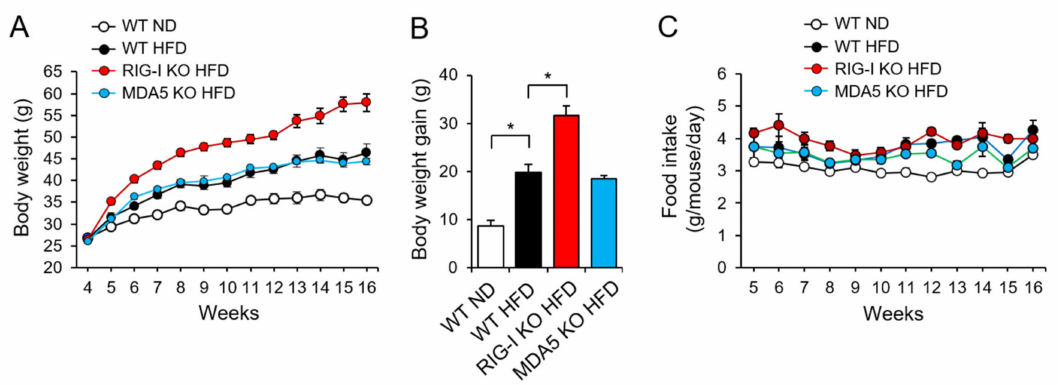
Figure 1. RIG-I deficiency exacerbates high-fat diet-induced obesity in mice. Wild-type (WT), RIG-I knockout (KO), or MDA5 KO mice were fed a normal chow diet (ND) or a high-fat diet (HFD) for 12 weeks. ( A ) Total body weight. ( B ) Body weight gain at 12-weeks. ( C ) Average food intake. The values represent the means ± SEM ( n = 4–5). * p < 0.05.